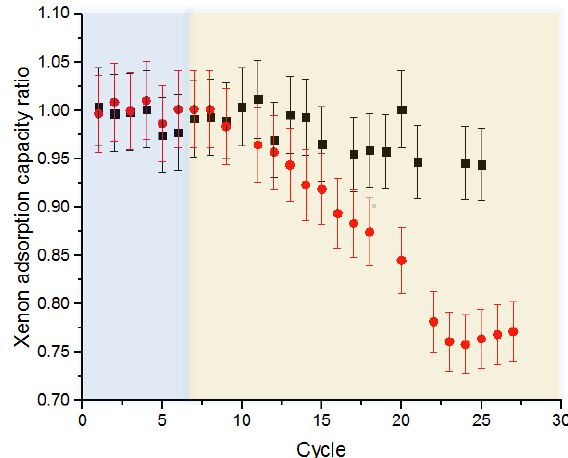
Figure 9. Aging of two Ag@ZSM-5 columns with and without chlorinated organic compounds. The blue background corresponds to the first phase with a contact time of 4 hours and a flow rate of 80 mL/min; the red background corresponds to a contact time of 19 h and a flow rate of 160 mL/min.